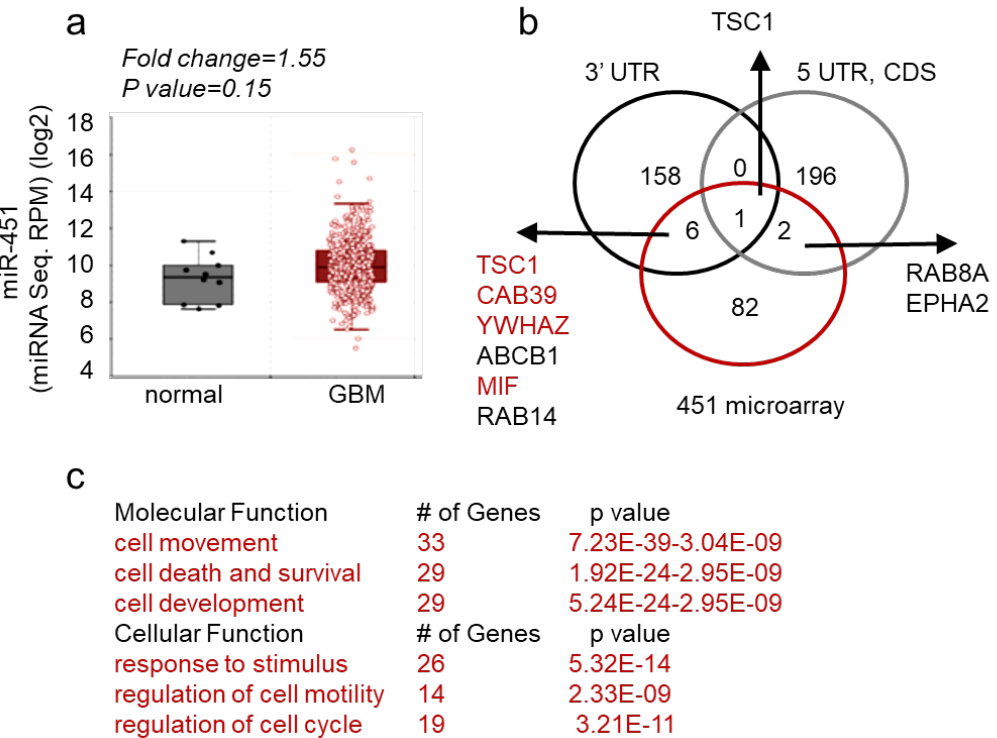
Figure 5. miR-451 expression in GBM and its targeted network. ( a ) MiR-451 is not significantly deregulated in GBM—microRNA sequencing of miR-451 in normal and GBM brain. Data source: TCGA. ( b ) Venn diagram showing number of genes deregulated in U87 and U251 cells stably overexpressing miR-451 (red), putative targets of miR-451 in 3 (cid:48) -UTRs (black) or 5 (cid:48) -UTRs and coding sequences (CDS) (grey)—based on TargetScan and miRWalk software. ( c ) Functional Annotation Analysis of major ontology categories of the genes down-regulated by miR-451 overexpression analyzed by IPA (Ingenuity ® Systems) (molecular function, upper table) and GO enrichment STRING software (cellular function, bottom